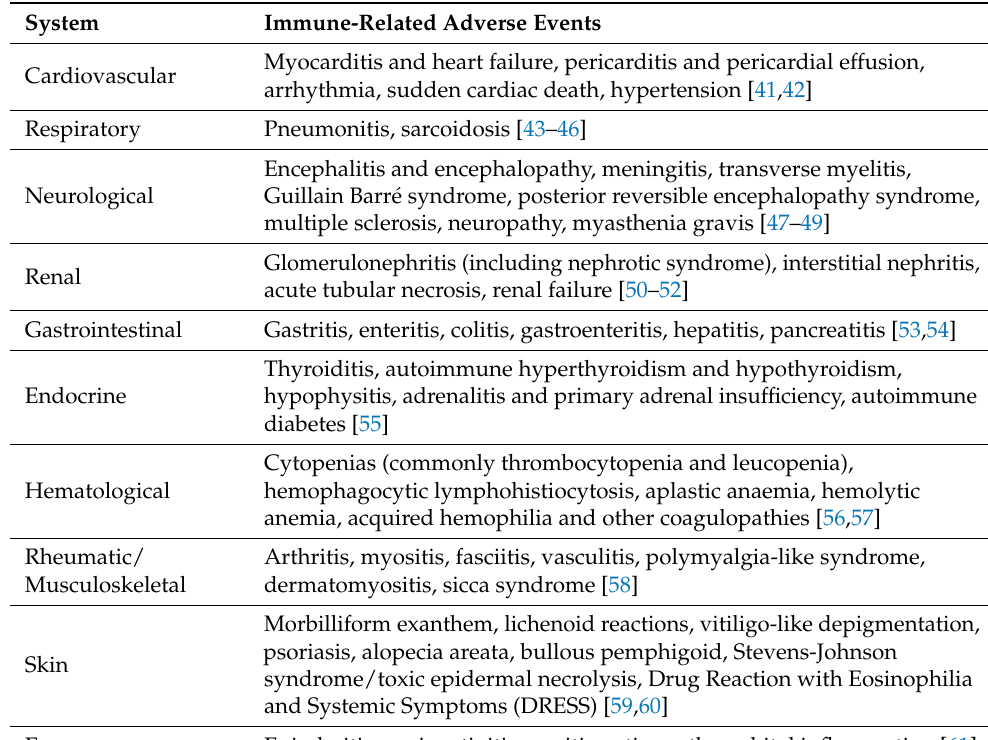
Table 1. Manifestation of Immune-Related Adverse Events in Various